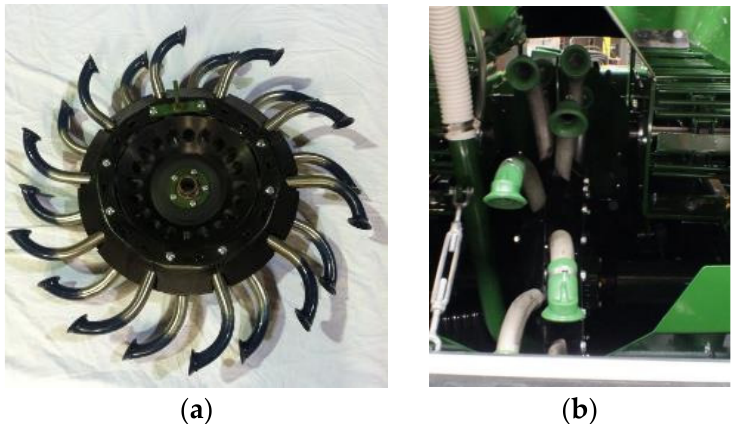
Figure 9. Pneumatic-type seed metering device. ( a ) The structure of a pneumatic-type seed metering device. Reprinted with permission from ref. [49]. Copyright 2019 Lockwood Industries. ( b ) Pneumatic-type seed metering device in Lockwood Air Cup Planter. Reprinted with permission from ref. [49]. Copyright 2019 Lockwood Industries.